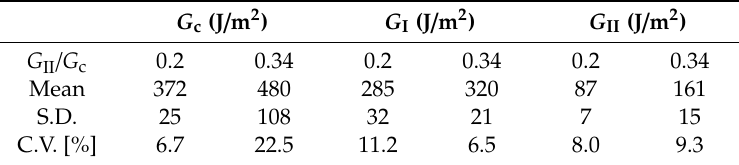
Table 3. ACDB results, static